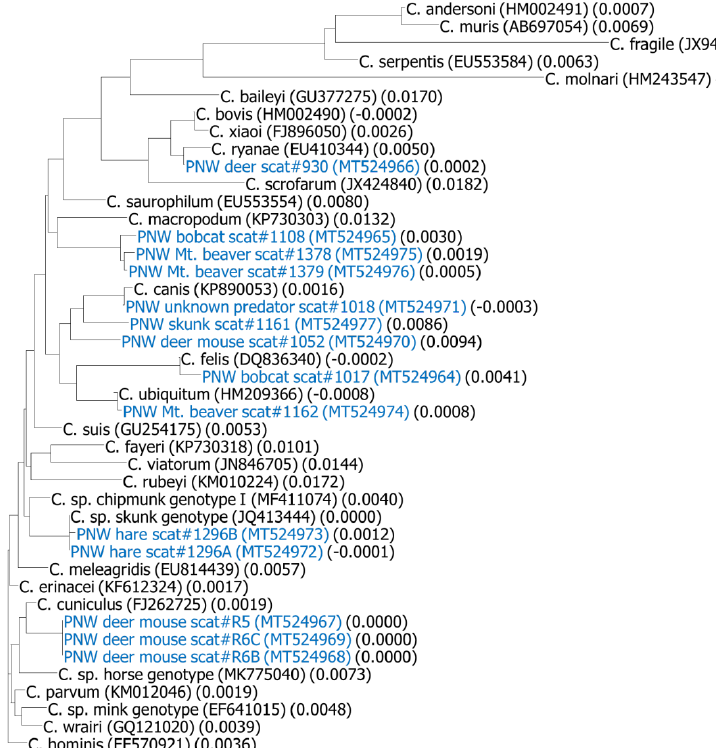
Figure 1. Phylogenetic dendrogram comparing Cryptosporidium isolates from a protected watershed in the Pacific Northwest (blue font) and representative archived Cryptosporidium species from fish, amphibians, reptiles, birds, and mammals, and selected zoonotic genotypes (black font). GenBank accession numbers are in the brackets behind the names of representative archived species or genotypes of Cryptosporidium . Names of isolates from the municipal watershed start with PNW followed by wildlife species, scat #, GenBank accession number, and calculated distance